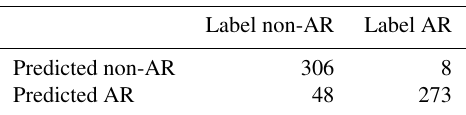
Table B6. Confusion matrix of the method for the testing set – the CAM5.1 data (daily, 200km). It shows the number of correctly recognized (the diagonal) and the number of incorrectly classified events